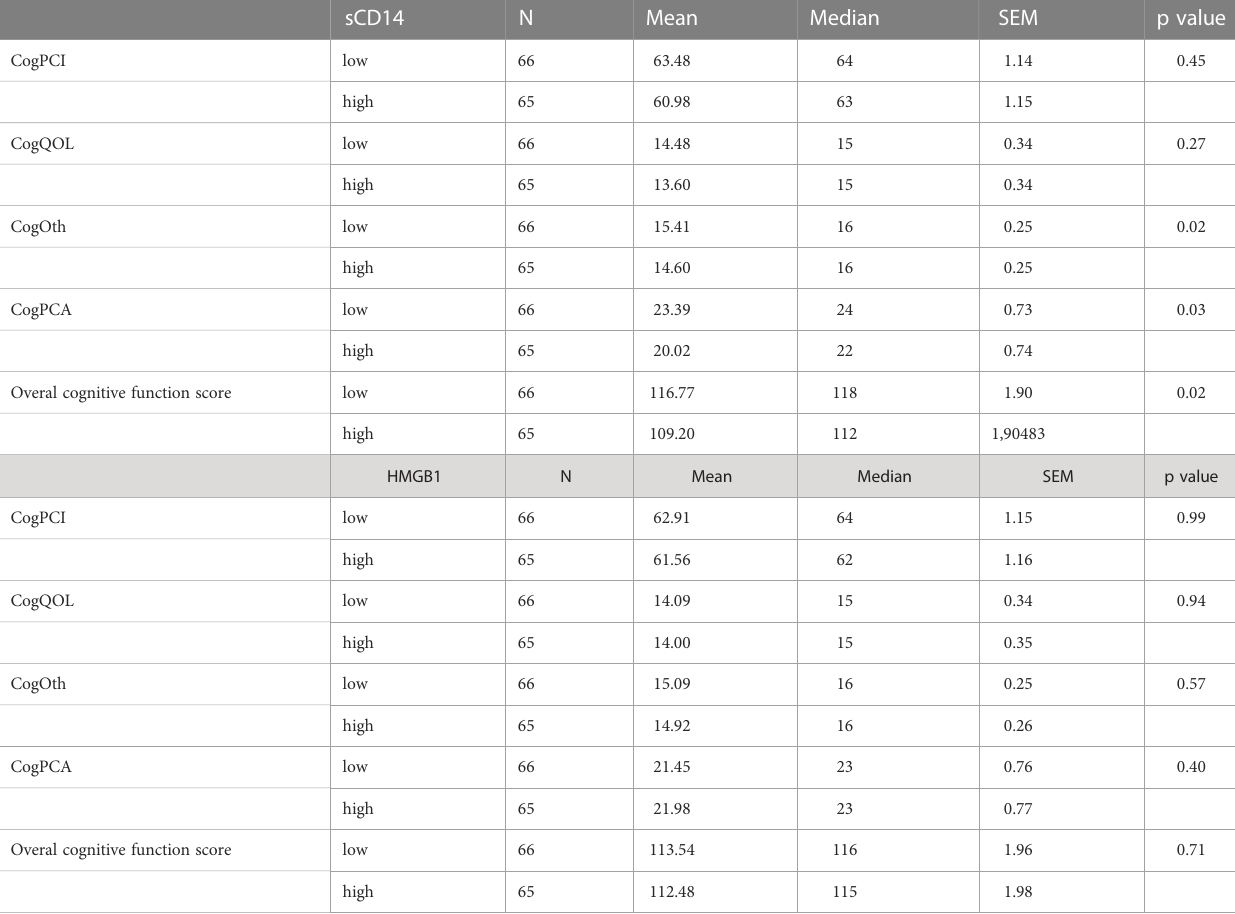
TABLE 2 Levels of biomarkers of gut microbial transfer and their association with cognitive